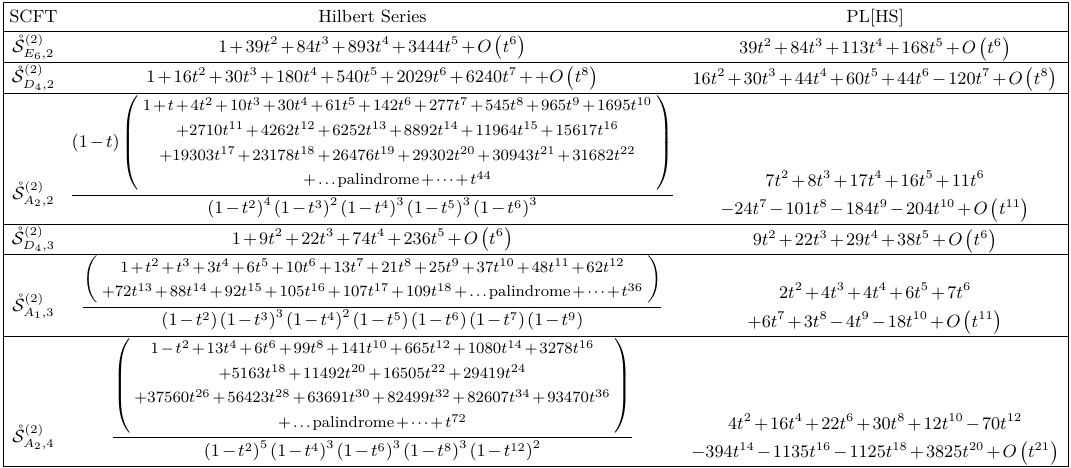
Table 12. Coulomb branch Hilbert series and plethystic logarithm for the magnetic quivers of ˚ S ( r =2)